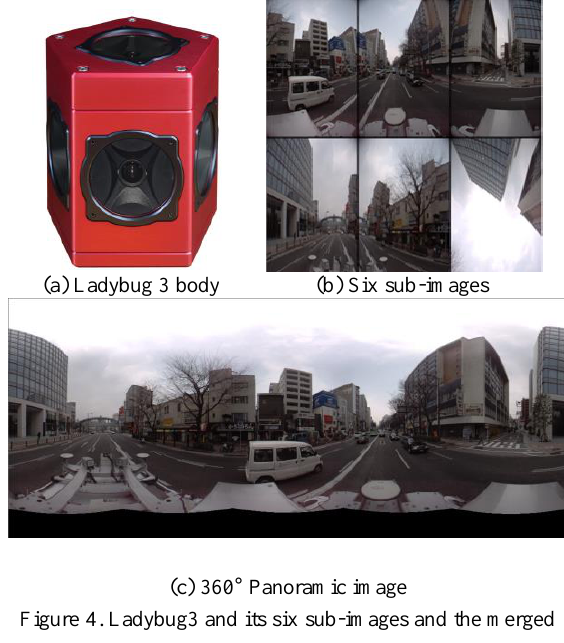
Figure 4. Ladybug3 and its six sub-images and the merged 360 ° panoramic